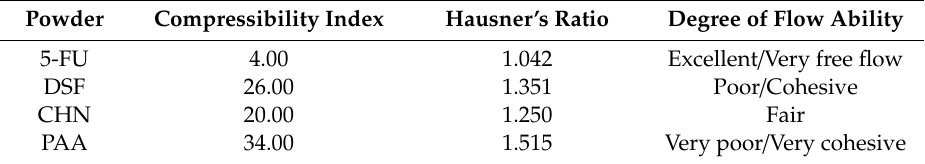
Table 5. Degree of flowability of each powder determined by their calculated CI and HR values. Powder Compressibility